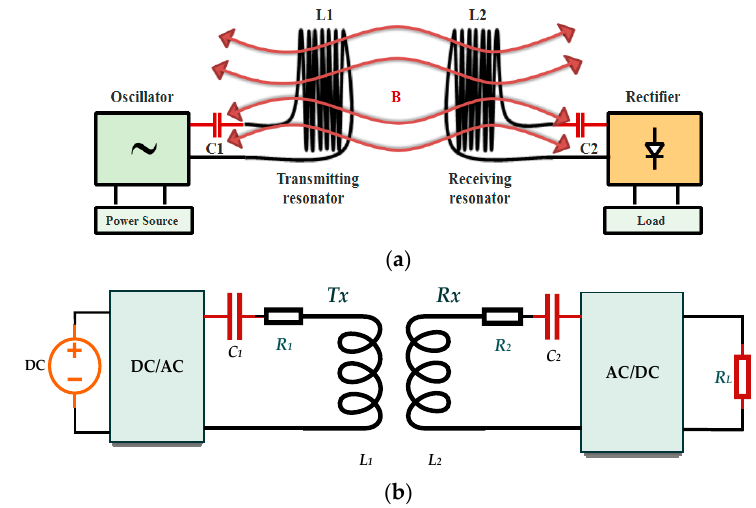
Figure 8. WPT system: ( a ) magnetically coupled resonance WPT (MCR WPT); ( b ) the equivalent circuit of series–series (SS)-compensated WPT.